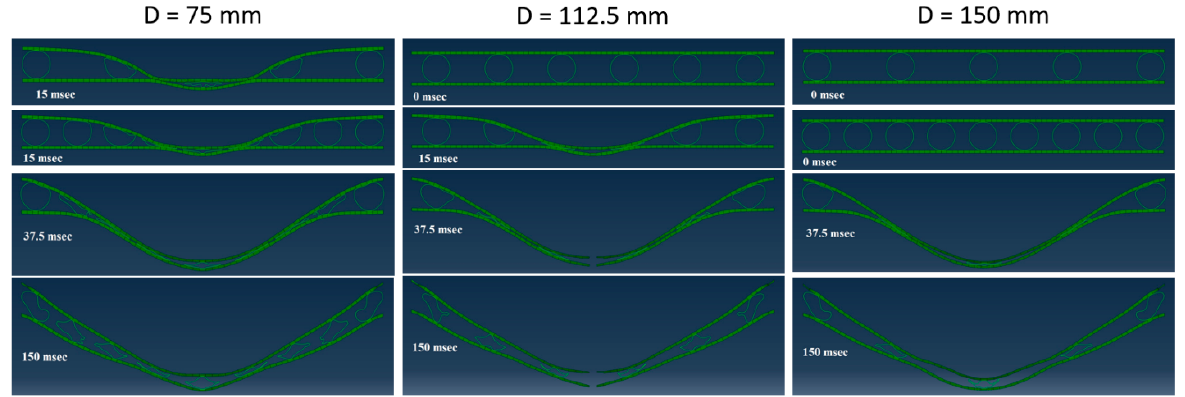
Figure 22. Damage development for tubular shape with façade plate thickness of 5 mm and core– core spacing of: 75 mm, 112.5 mm, and 150 mm.